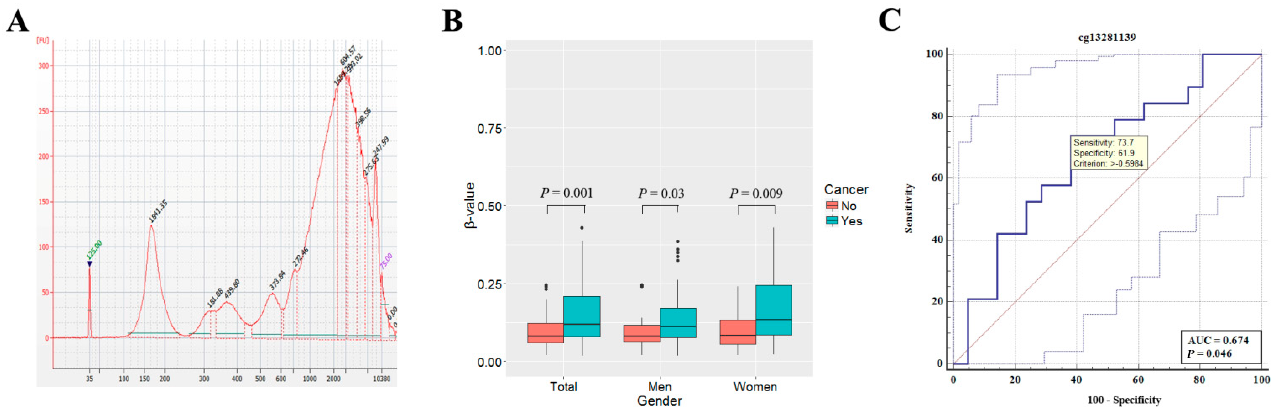
Figure 4. Analysis of SLIT2 methylation in plasma cell-free DNA of NSCLC patients. ( A ) Cell-free DNA extracted from plasma was analyzed using an Agilent DNA high sensitivity Kit on an Agilent Bioanalyzer 2100 instrument. Electropherogram shows representative sample with contaminated genomic DNA fragments longer than 400 bp. ( B ) Methylation levels of SLIT2 (cg13281139) in plasma cell-free DNA were compared between 72 NSCLC patients and 61 cancer-free patients according to gender. p -values were based on Wilcoxon rank sum test. ( C ) True positive (sensitivity) and false positive (1-specificity) rates of a logistic regression model based on cg13281139 in plasma cell-free DNA were evaluated with a test dataset ( N = 40). ROC curve with 95% confidence interval was plotted using the MedCalc software (version 19.0.5).